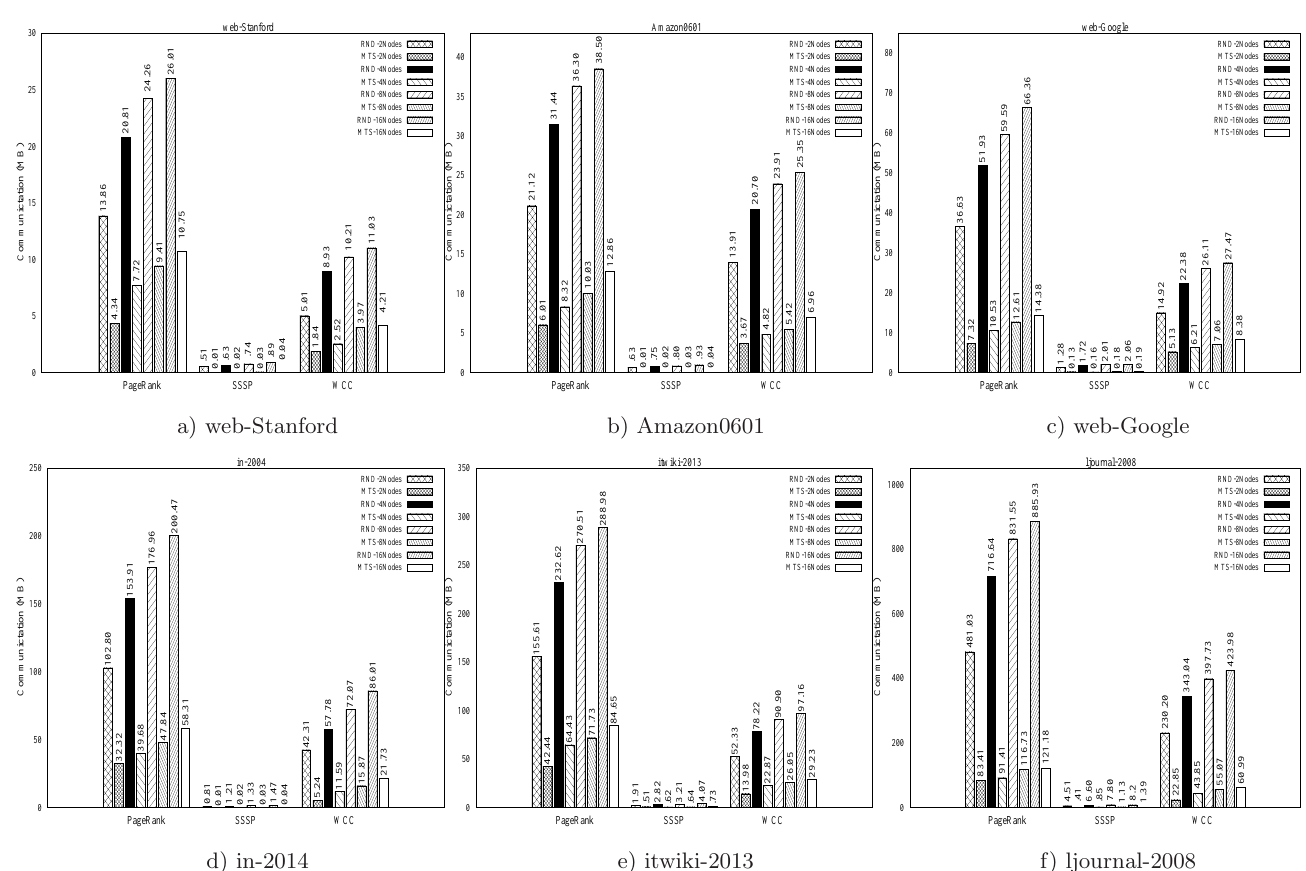
Figure 7. Communication Cost performance metric for web-Stanford, Amazon0601, web-Google, in-2004, itwiki-2013 and ljournal-2008